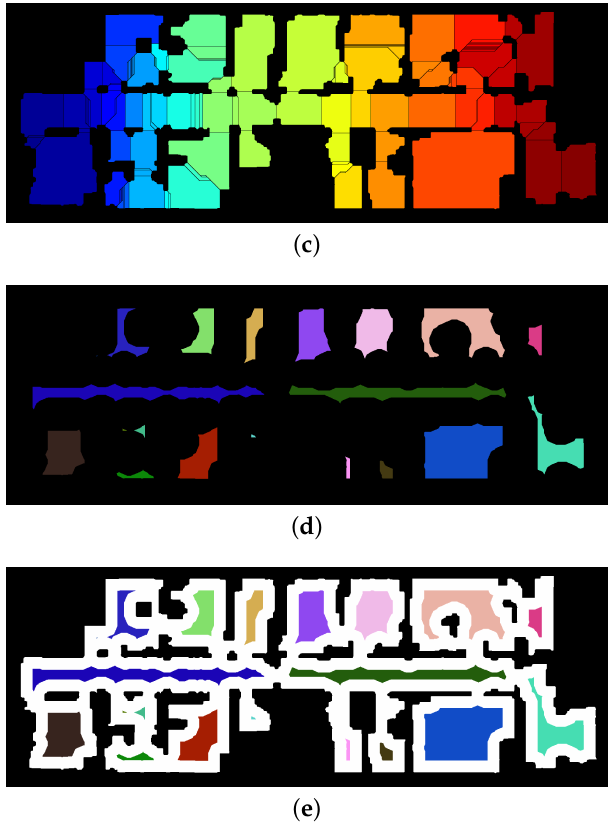
Figure 2. Grid map segmentation using the watershed algorithm: ( a ) The grid map image. ( b ) The normalized distance transform. ( c ) Over-segmentation after application of the basic watershed algorithm. ( d ) Markers labeled using the connected component labeling algorithm; the different colors indicate different labels. ( e ) Predetermined markers for marker-controlled watershed segmentation; the white areas are